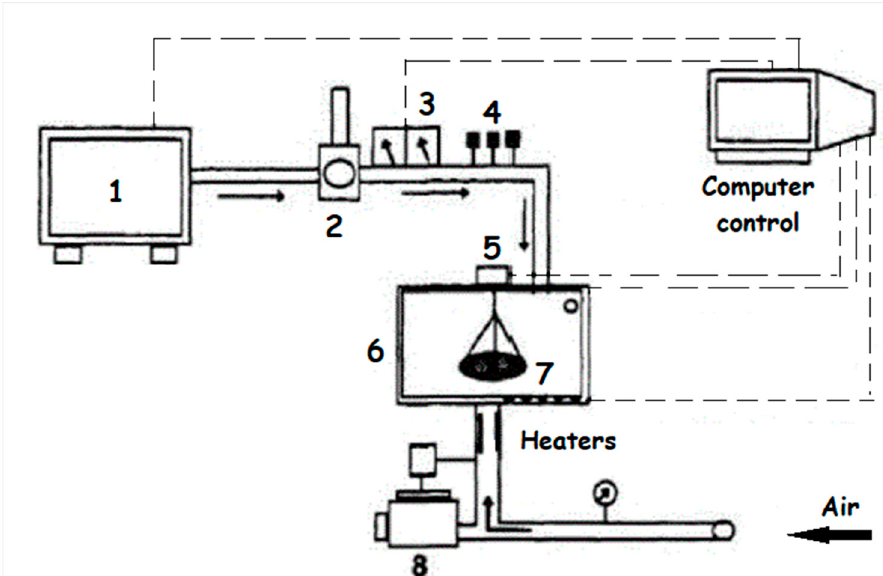
Figure 13. Dryer equipment (1: microwave generator, 2: circulator, 3: power meters, 4: adjusting controls, 5: weight balance, 6: microwave chamber, 7: sample support, and 8: fan).